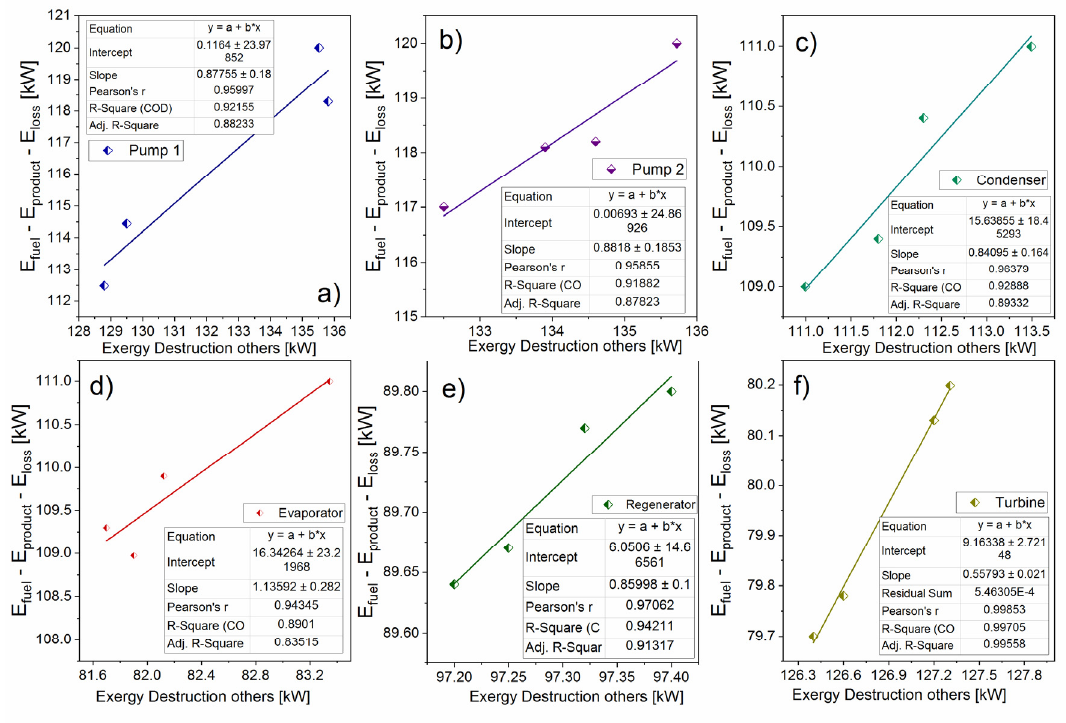
Figure A1. Endogenous destruction of exergy for heptane ( a ) Pump 1, ( b ) Pump 2, ( c ) condenser, ( d ) evaporator, ( e ) regenerator, and ( f ) turbine.